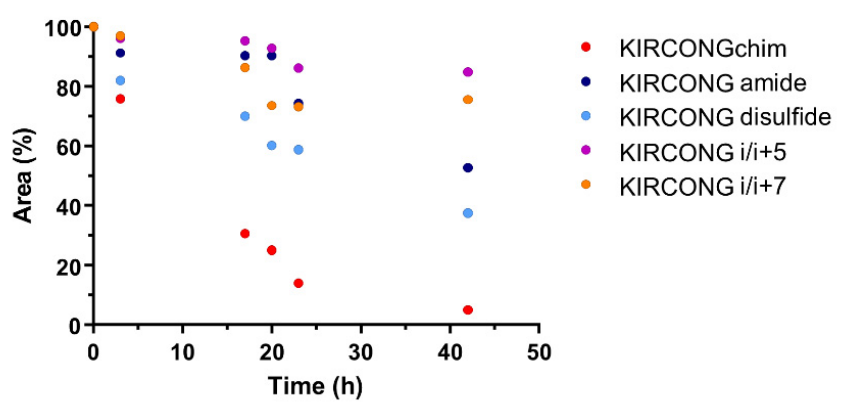
Figure 4. Serum stability assay of KIRCONG chim derivatives. The serum stability was evaluated by incubation in 25% FBS for 42 h. Residual peptide amount is expressed as the percentage of the initial amount versus